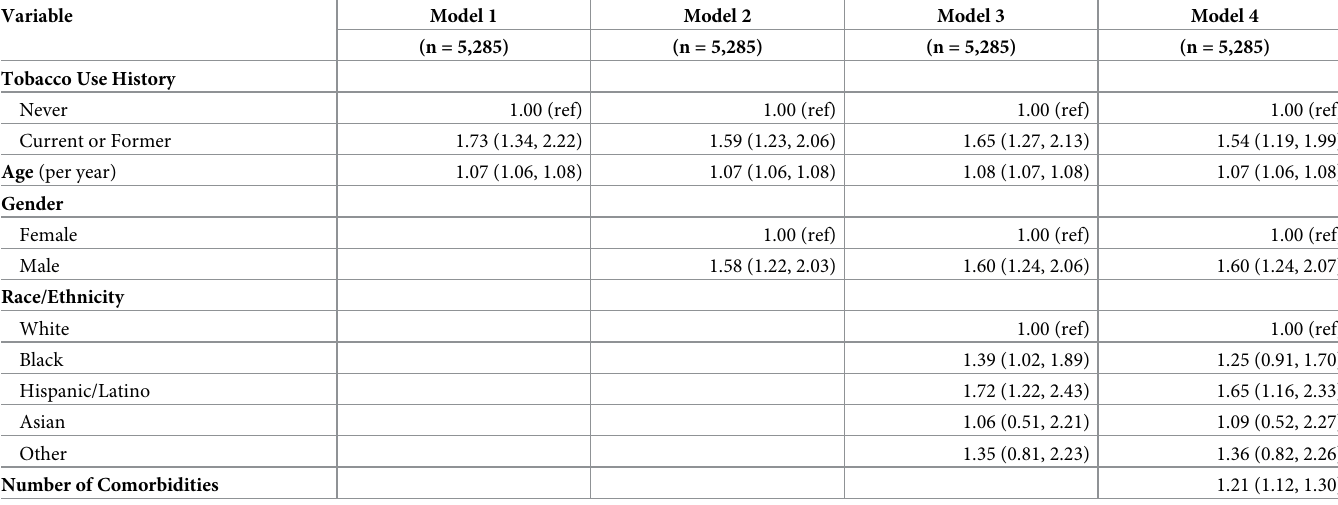
Data are odds ratios (95% CI) p values were calculated by multivariable logistic regression. Age (n = 8,874), Gender (n = 8,872), Race/Ethnicity (n = 8,874), BMI (n = 5,103), Number of Comorbidities (n = 8,836), Tobacco Use History (n = 5,285). The likelihood ratio test x 2 = 417.36; p-value <